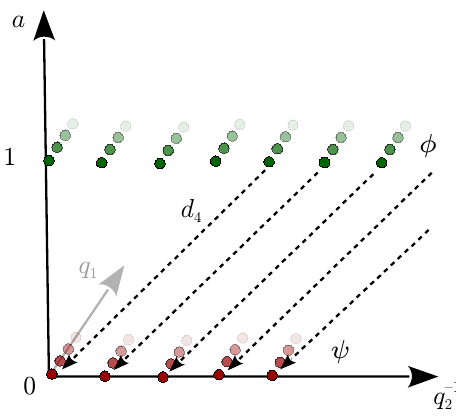
Figure 13 . A visualization of the single-particle states in H BPS for the resolved conifold. Three axes correspond to Z 3 gradings corresponding to fugacities q 1 ; q 2 and a . One particle states (cid:30) i;j and i;j span two quadrants in ( q 1 ; q 2 ) plane shifted by 1 along a axis. Dashed arrows show the action of d 4 di(cid:11)erential which has U(1) q charge zero and maps Z -graded towers to Z -graded 1